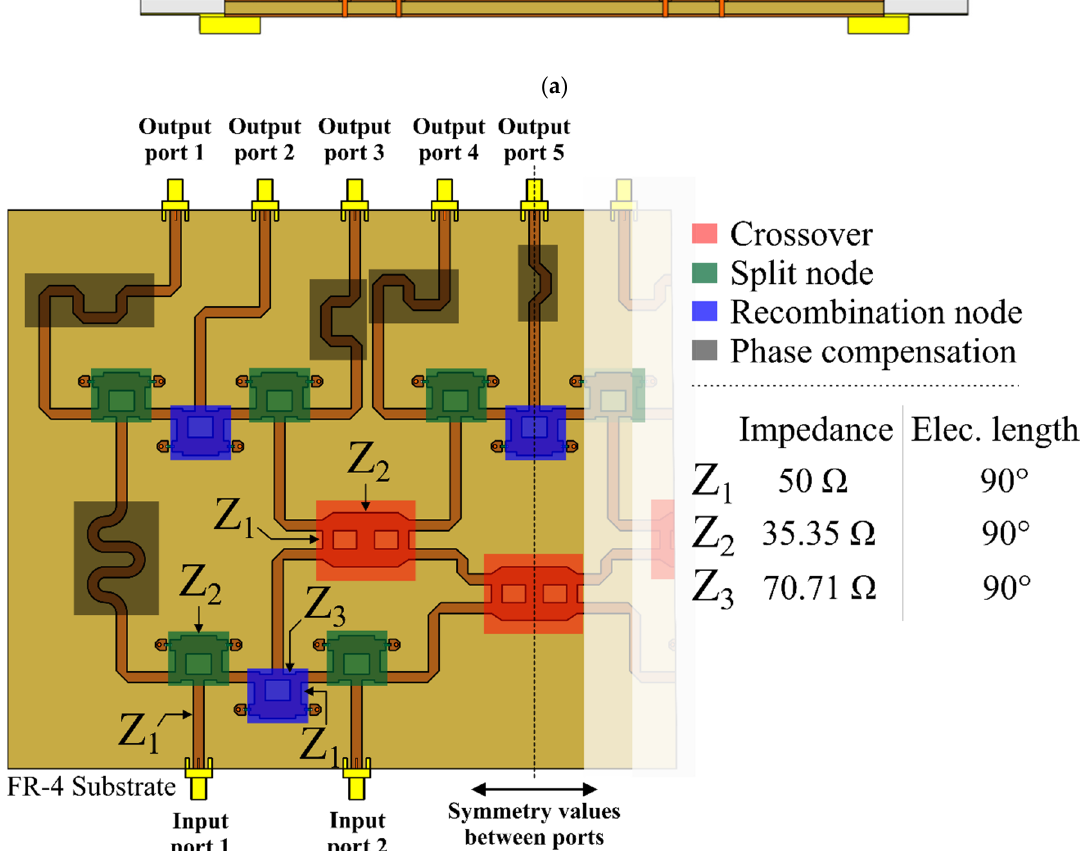
Figure 5. Design of the proposed feeding system based on 4 × 9 CORPS network: ( a ) Design in CST Microwave Studio, ( b ) components and values of the characteristic impedances of all transmission line sections.